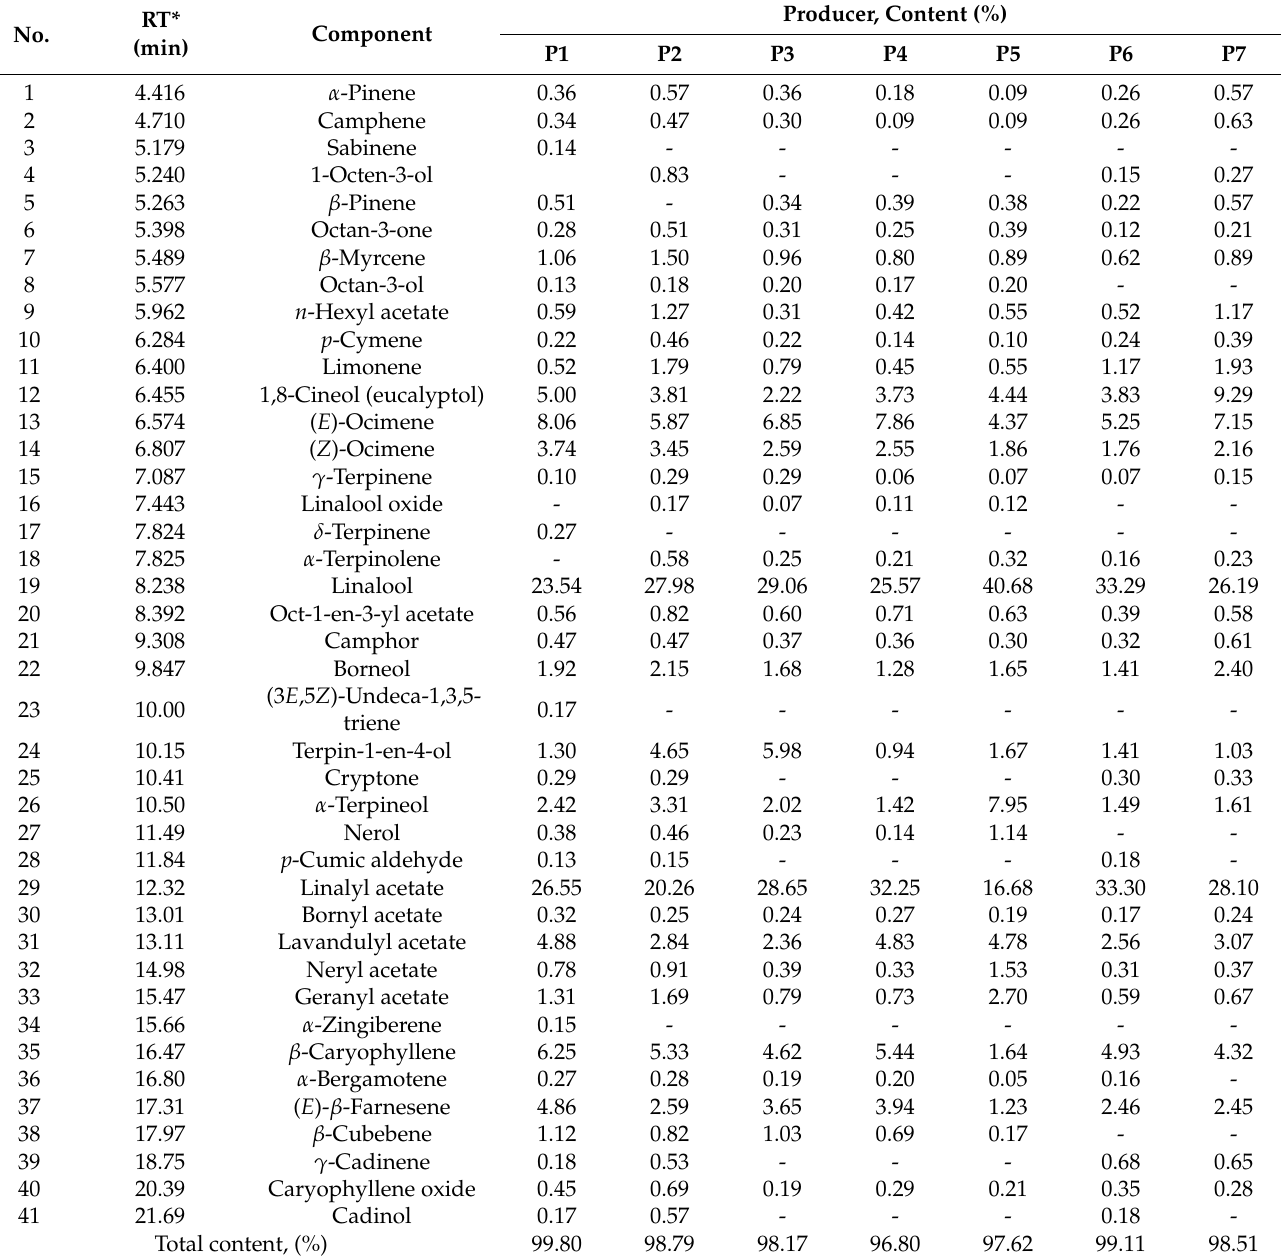
Table 1. Phytochemical (terpenic and aliphatic compounds) composition of lavender essential oil of Moldovan origin.